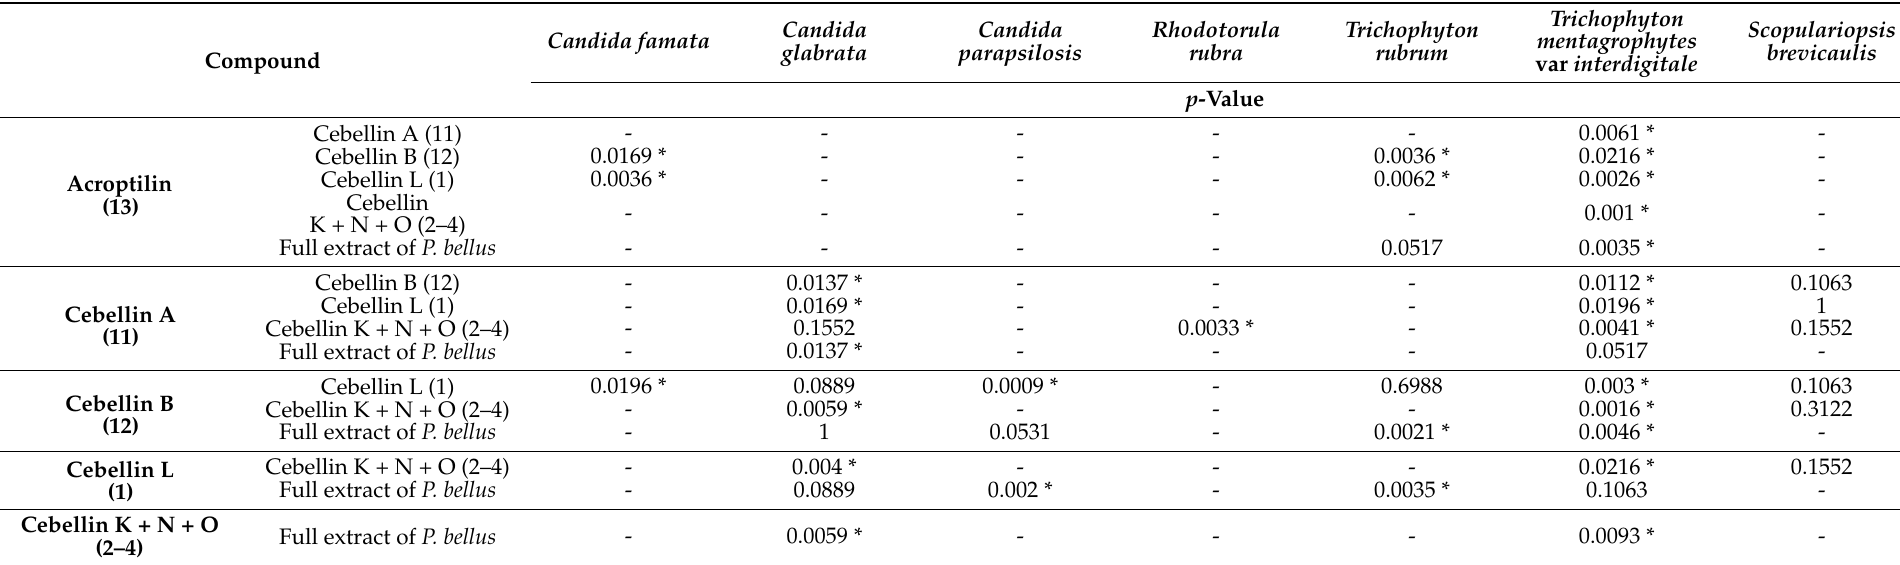
Table 3. The results of the difference test between averages for the examined compounds in relation to various fungal